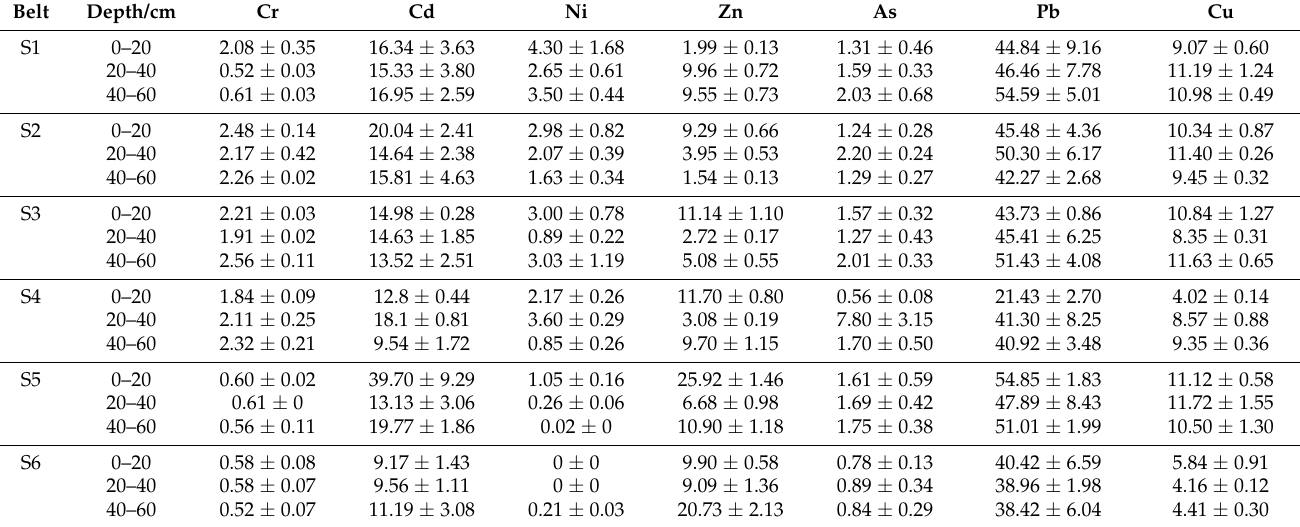
Table 5. K values (%) for heavy metals in the soil samples from An-tea plantations.